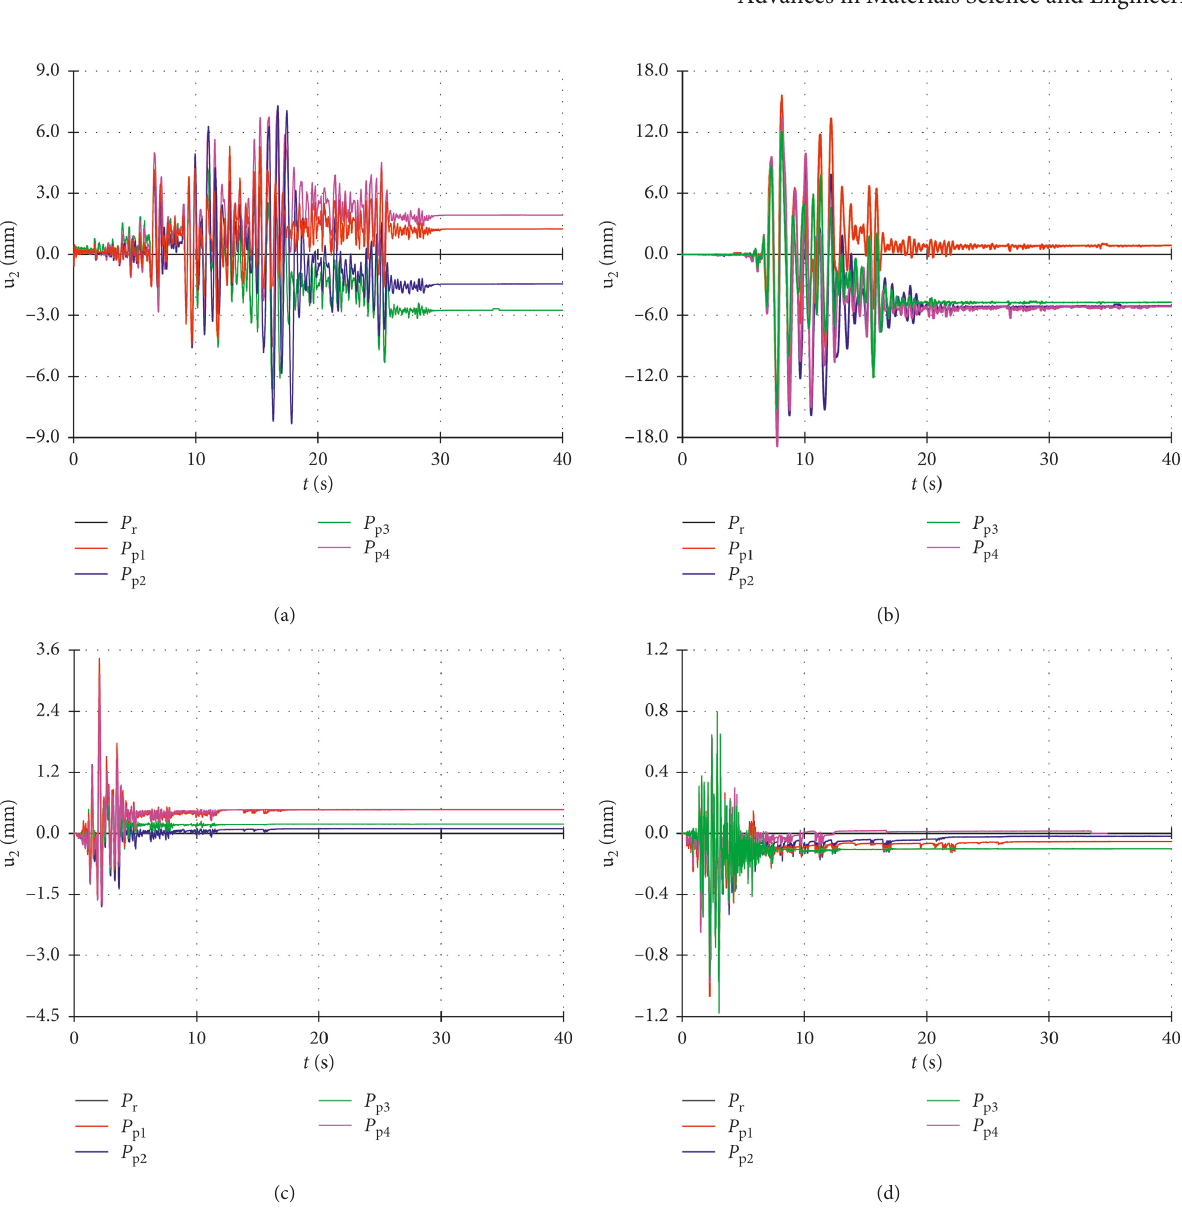
) for MSB. (a) Artificial accelerogram (AA). (b) Accelerogram Petrovac (AP). 2